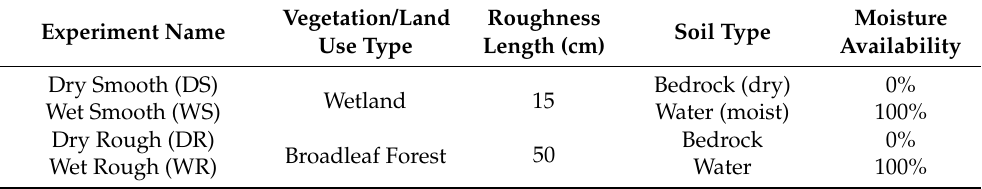
Table 1. Experiment names and set-ups of land surface